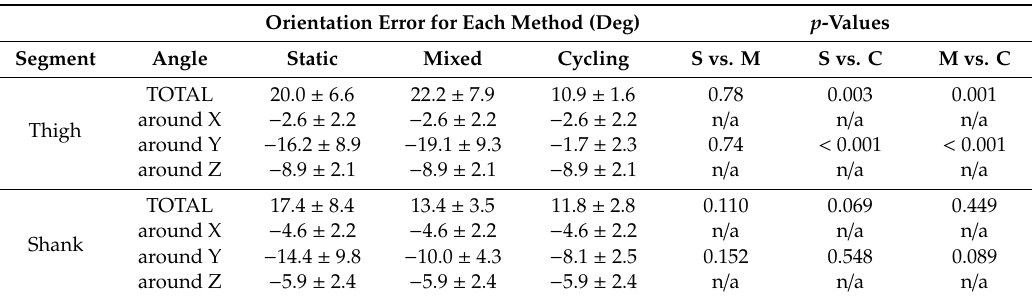
Table 3. Mean di ff erences in body segment orientations using the anatomical and technical frames. Di ff erences were expressed as the smallest rotation angles for thigh and shank. Di ff erences were also expressed as Euler angles around the anteroposterior X -axis, longitudinal Y -axis, and medio-lateral Z -axis for the thigh and shank. ** denotes a significant di ff erence, with p < 0.01. Orientation Error for Each Method (Deg) p -Values Segment Angle Static Mixed Cycling S vs. M S vs. C M vs. C